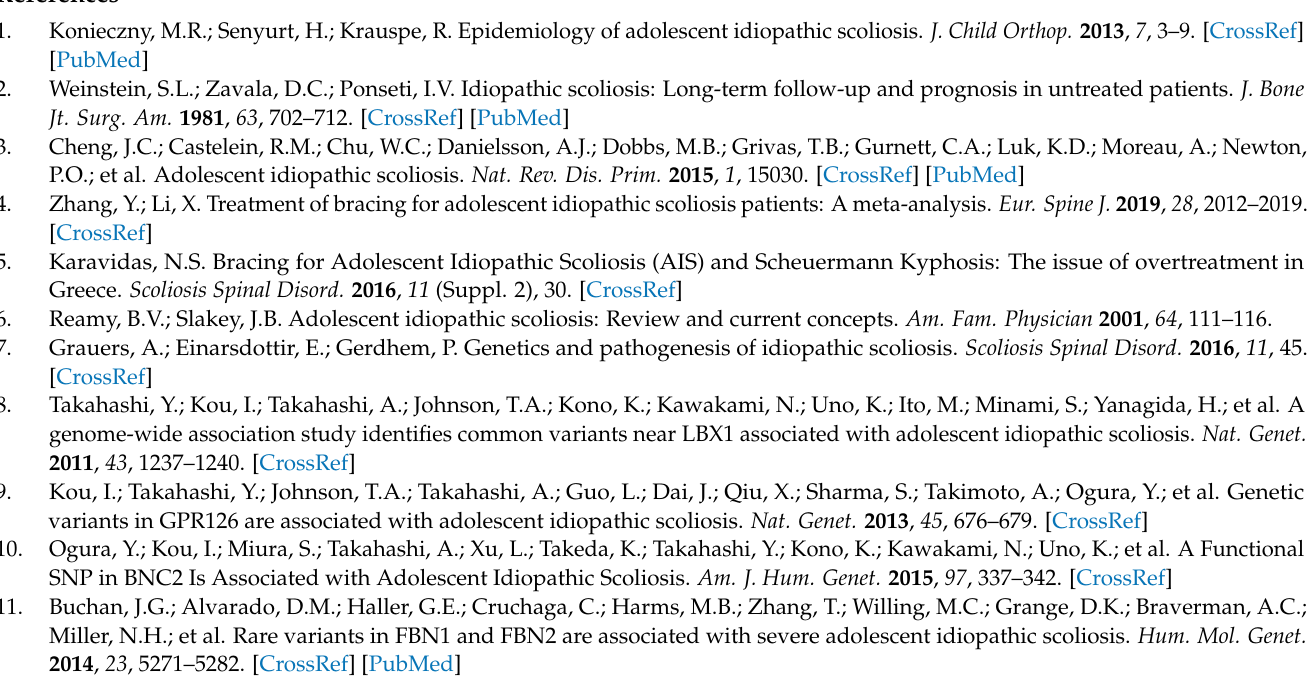
Table S6: Knockout mouse phenotypes enriched in AIS candidate genes; Table S7: GO terms enriched in AIS candidate genes; Table S8: Pathogenic rare variants on TTN and CLCN1